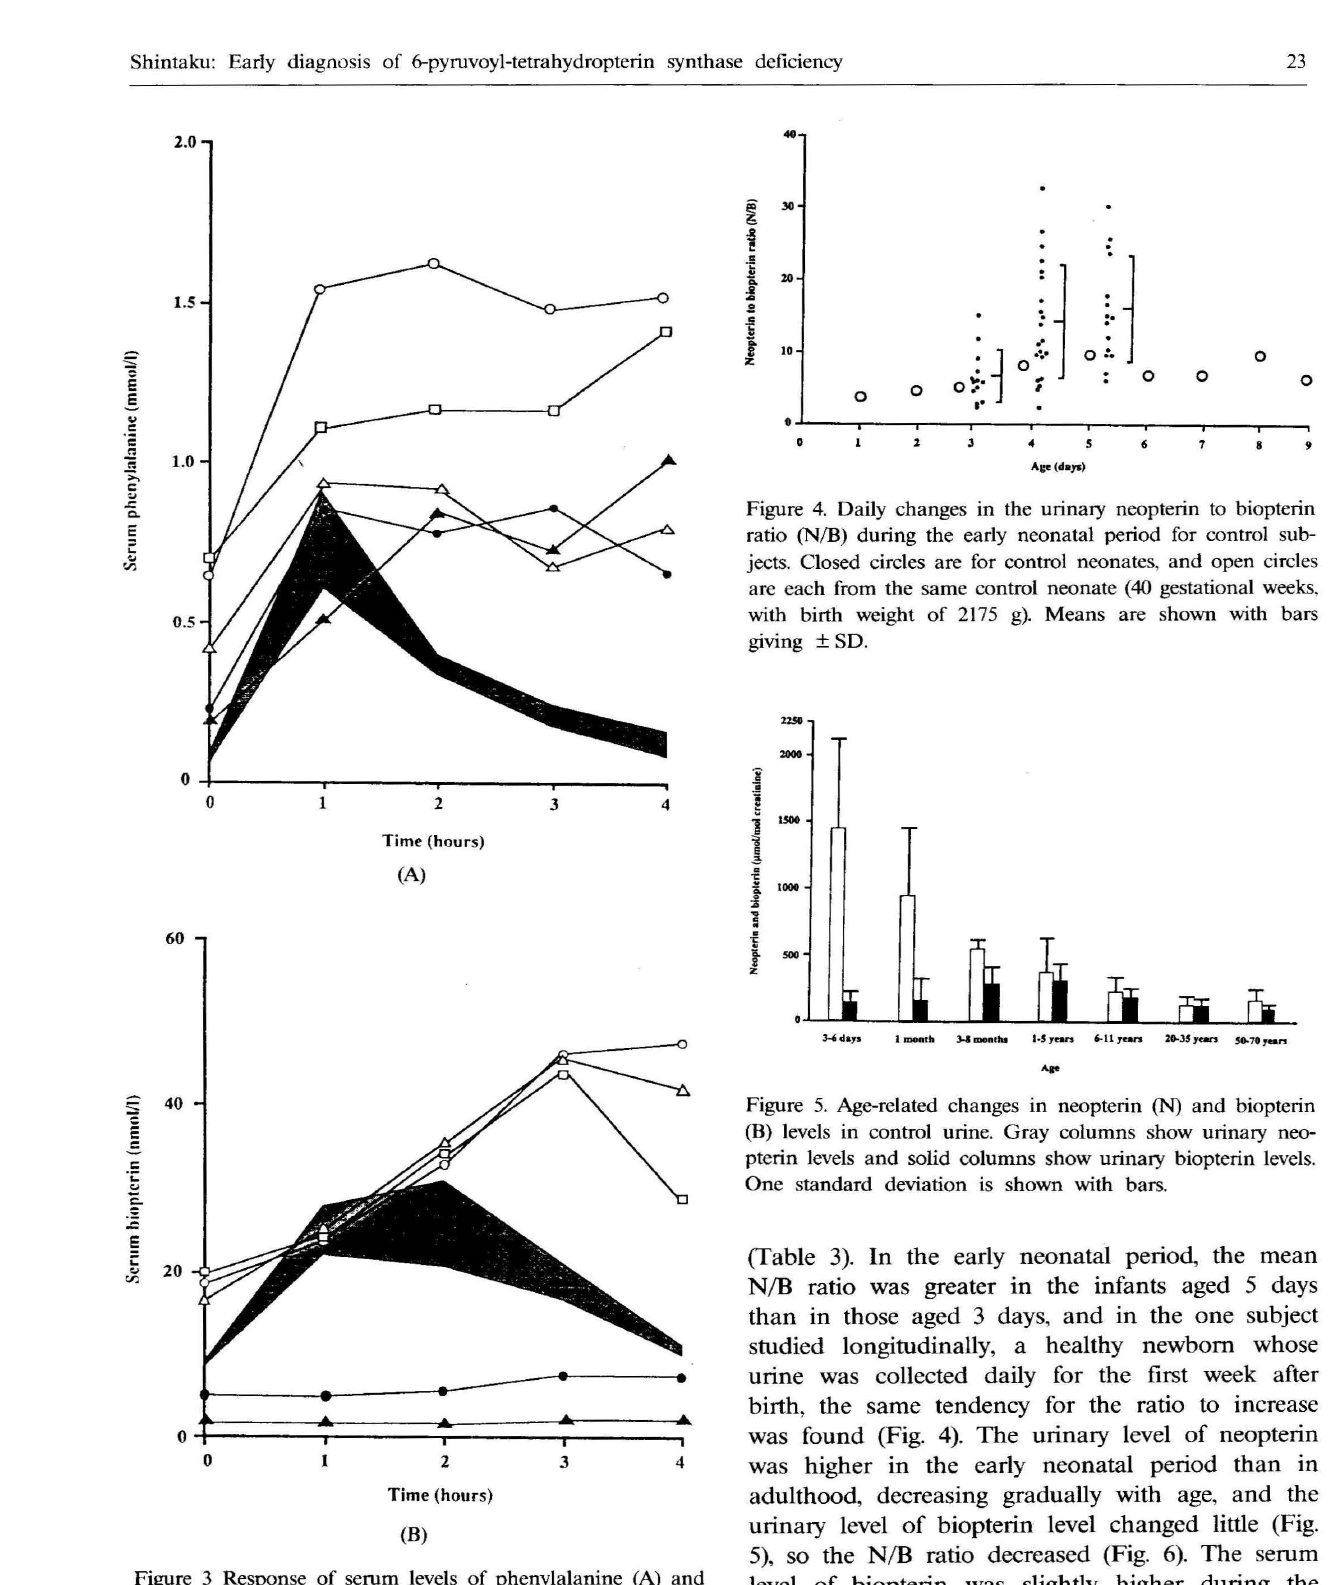
Figure 5. Age-related changes in neopterin (N) and biopterin (B) levels in control urine. Gray columns show urinary neo pterin levels and solid columns show urinary biopterin levels. One standard deviation is shown with bars